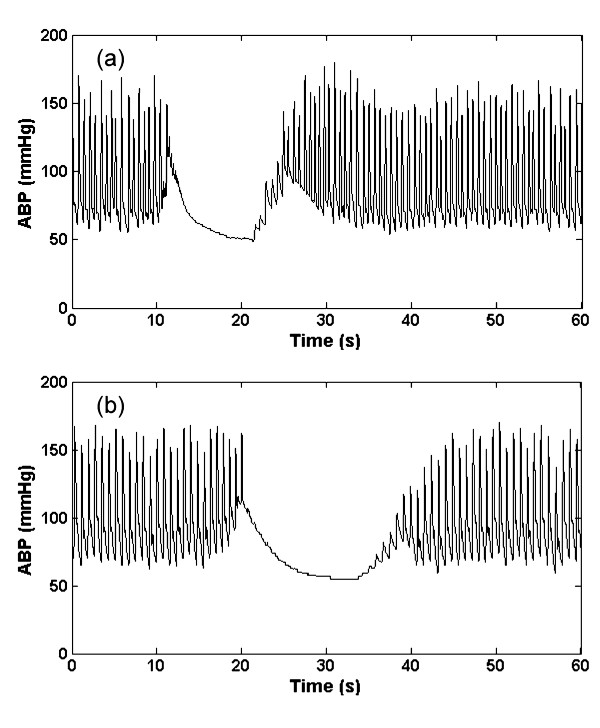
Artifact 2, (asmin); Real (a) and Simulated (b) ABP saturation to lowest pressure in window defined by Eq.s (2) and (3).